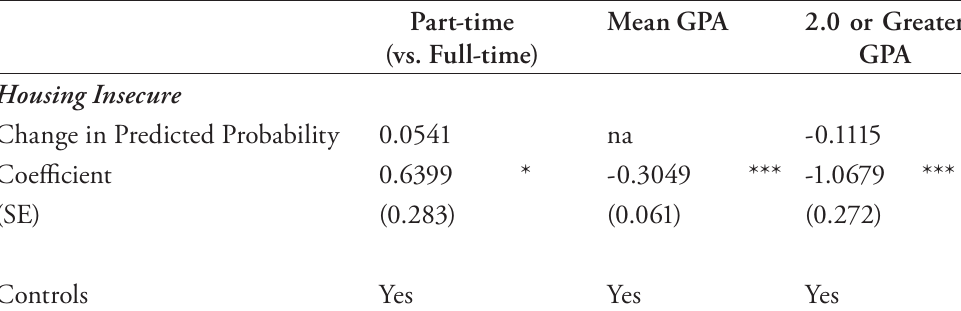
Table 3: Relationship between housing insecurity and academic success in the